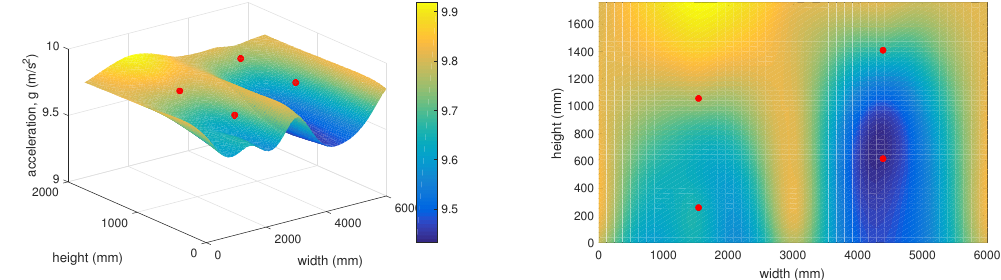
Figure 17. Vector sum of acceleration at